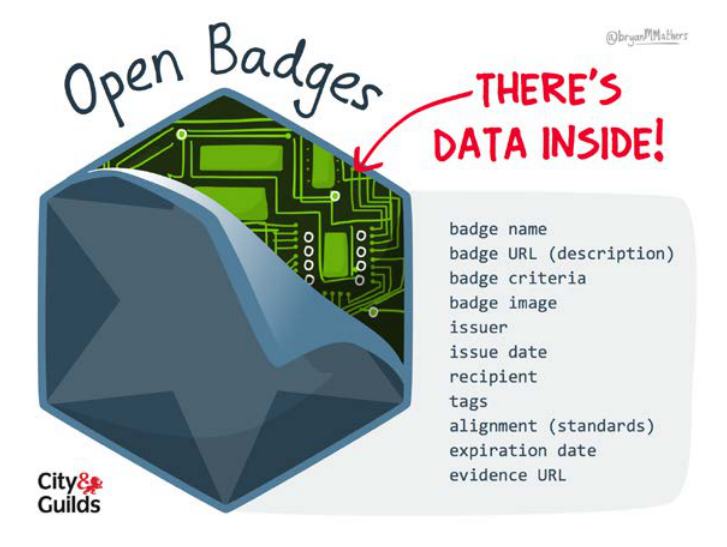
Figure 3. A visual representation of the kinds of data that can be included in an open badge. Adapted from “ Open badges (P.S. there’s data inside…),” by Mathers, 2019 (https://bryanmmathers.com/open-badges- data-inside/). Image is licensed